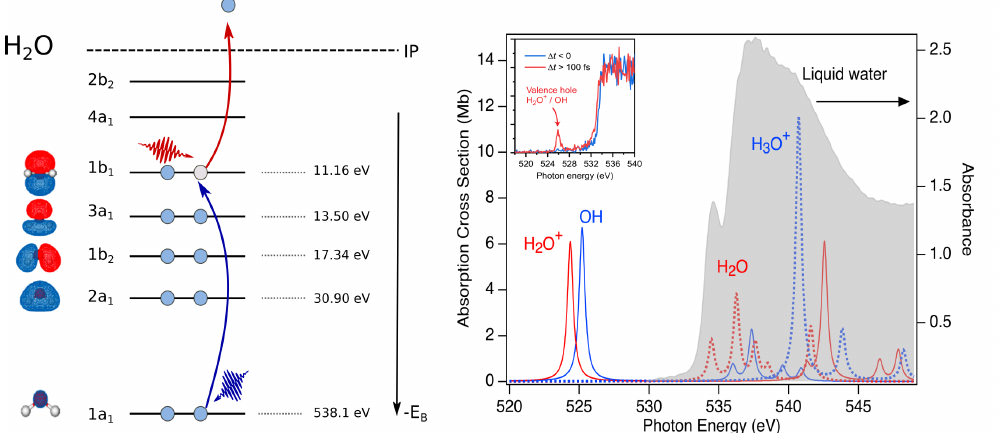
Figure 2. Schematic of optical pump/X-ray probe transient absorption study of water radiolysis. Left: Strong-field laser pump (red photon) ejects an electron from the outermost 1 b 1 orbital. X-ray probe (blue photon) induces the transition from the core 1 s level to the vacancy in the 1 b 1 (1 a 1 → 1 b 1 ). Right: Absorption spectrum of liquid water for a thickness of 800 nm [42] in gray. Calculated gas phase absorption for H 2 O + and OH. Liquid phase binding energies for electrons in the various orbitals [43]. Inset shows the experimental X-ray transient absorption spectrum of the OH(aq) radical. Reproduced from Reference